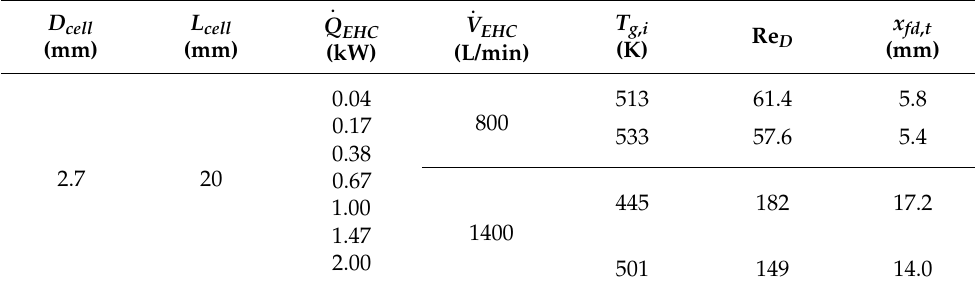
Table 2. Measurement conditions of surface temperature at the EHC outlet. D cell